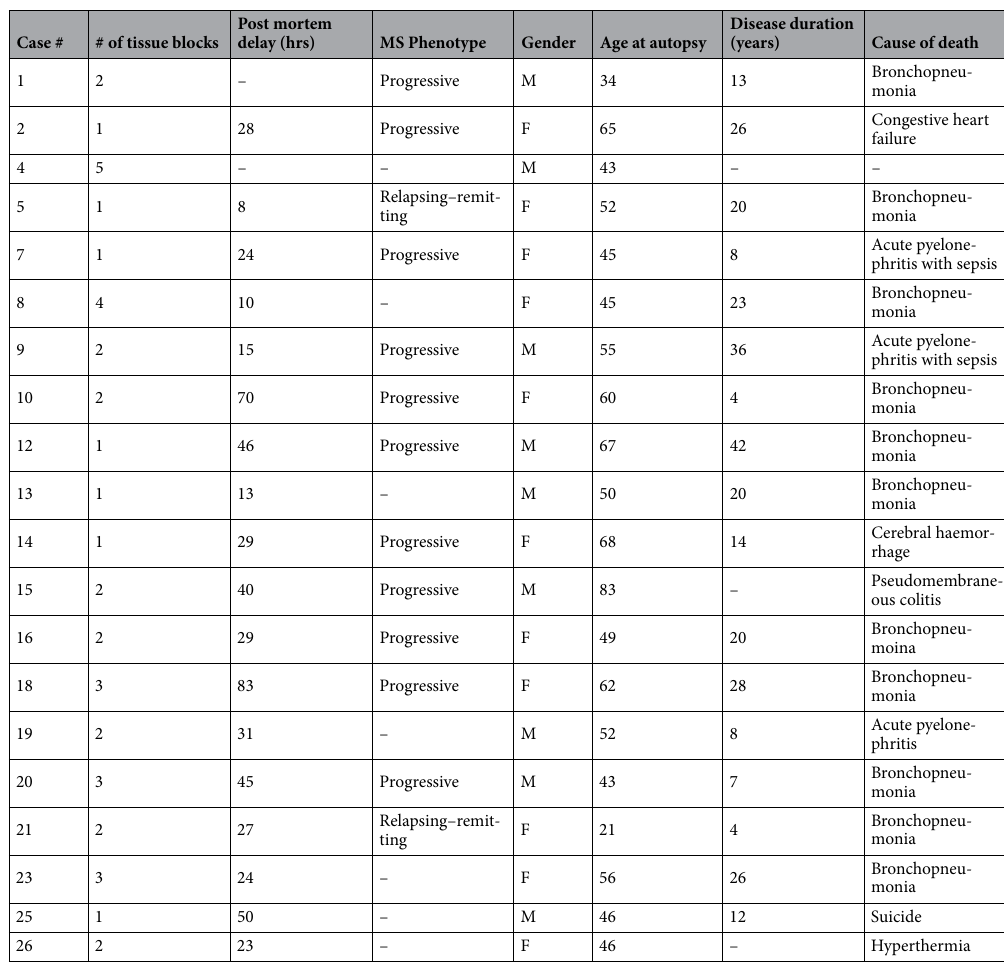
Table 1. Clinical and demographic case description of brain autopsy cases. – Information not